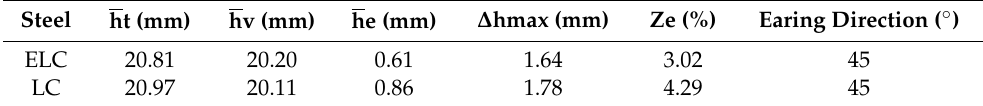
Figure 15. Photograph of draw cups and earing heights at varied angels from rolling direction.